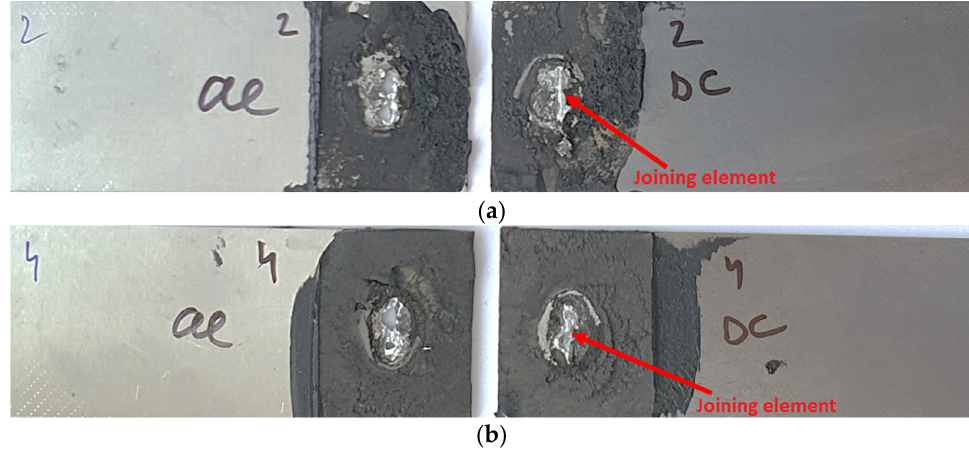
Figure 11. Fracture surfaces of Al-DC test joints made by resistance spot welding and AB after tensile shear test: ( a ) sample 2 and ( b ) sample 4, rubber based adhesive.